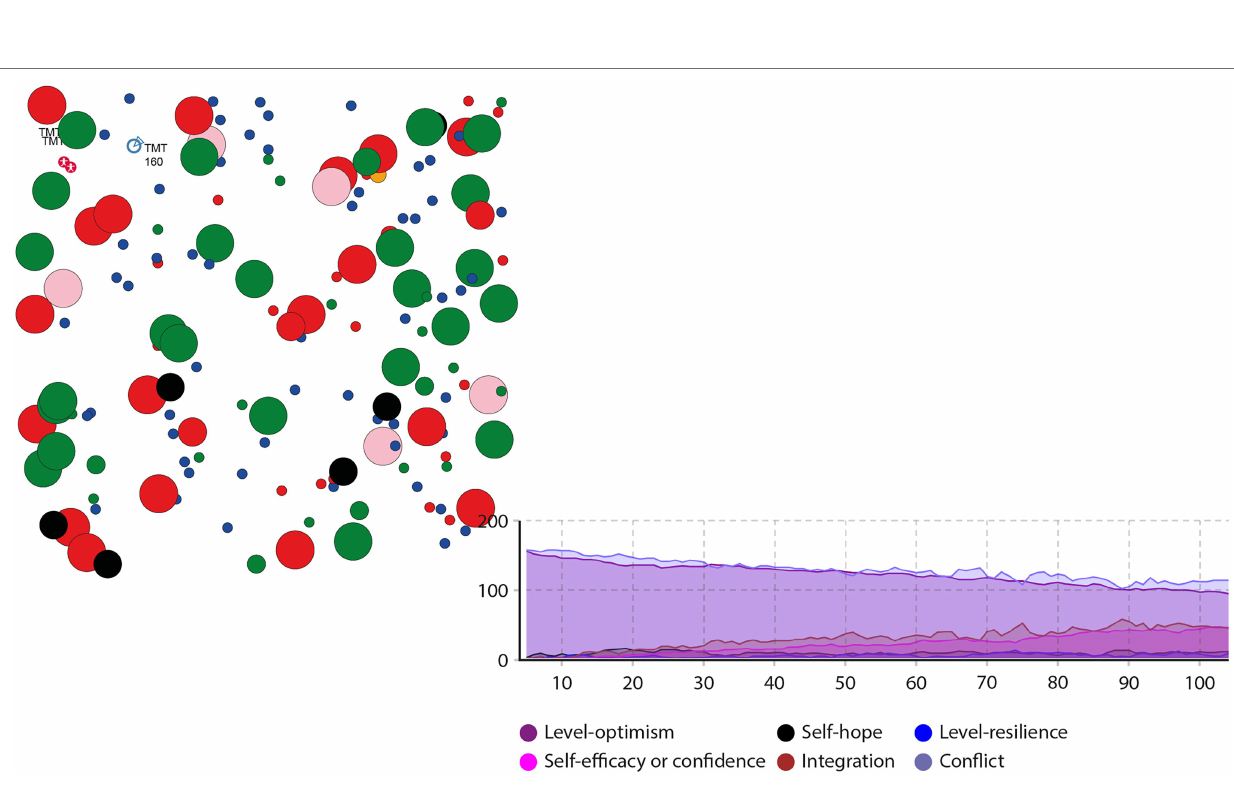
FIGURE 4 | System dynamics analysis model and data.